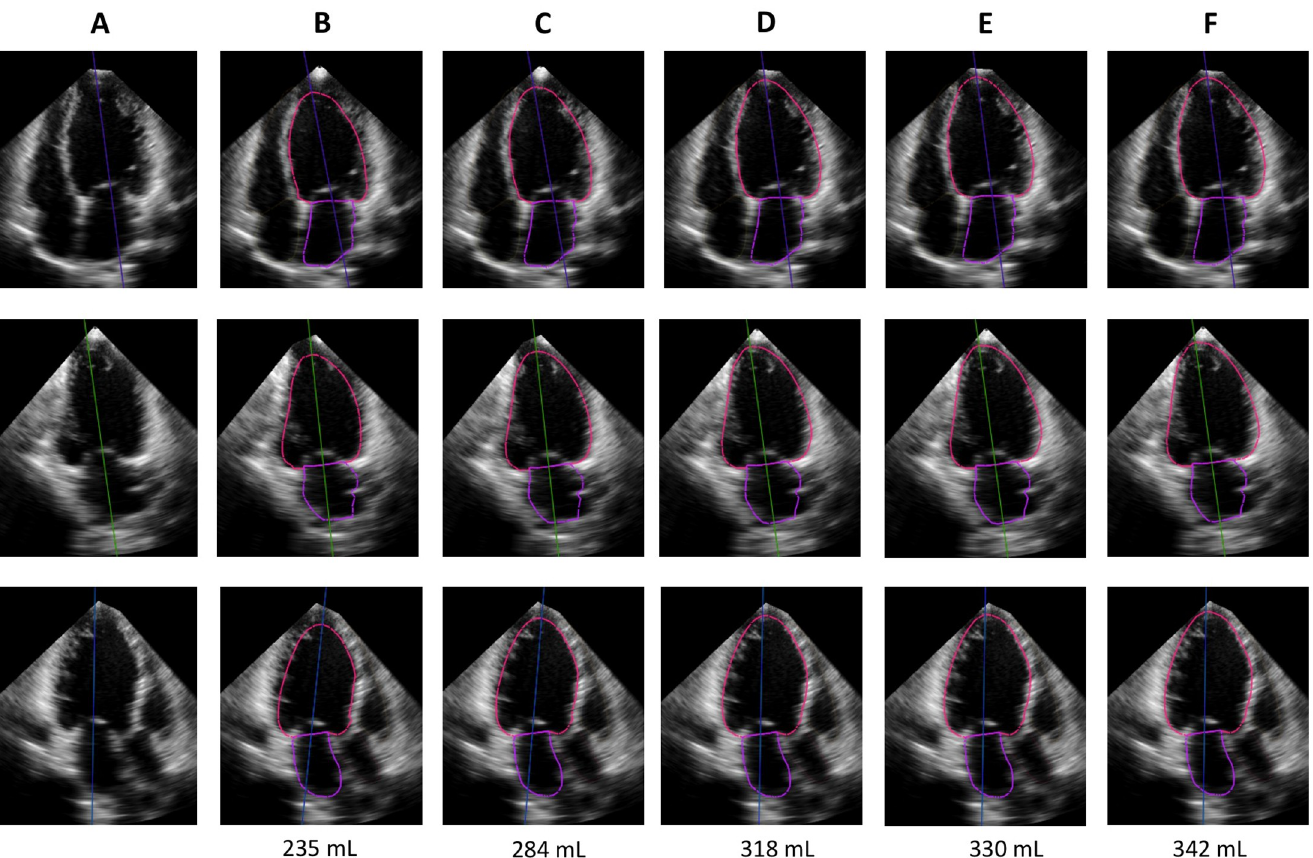
Fig 6. Left ventricular end-diastolic endocardial border tracing line used by different LV endocardial border threshold in a representative case. Upper, middle, and lower panels show apical 4-chamber, 2-chamber, and long-axis views extracted from 3D dataset. A, no border line; B, border threshold of 0; C, border threshold of 50; D, border threshold of 80; E, border threshold of 90; F, border threshold of